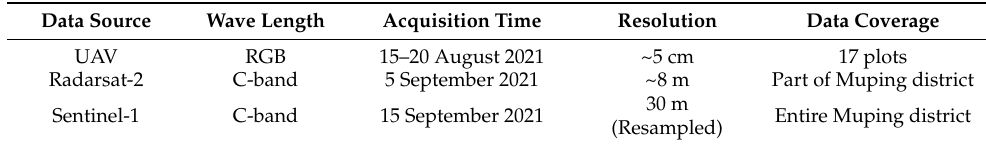
Table 1. Overview of multi-scale data used in this